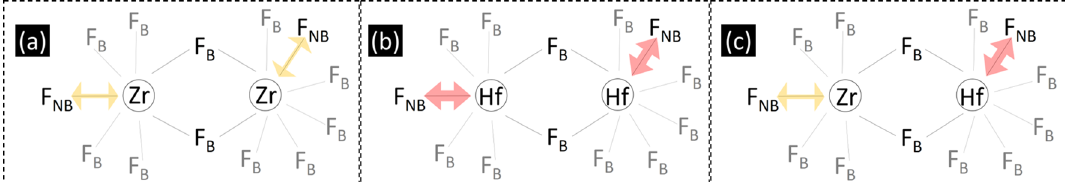
Figure 10. Electron cloud of terminal/non-bridging fluorines(F NB ) experiencing ( a ) moderate distortion from Zr atoms in pure ZBLAN glasses ( b ) High distortion from Hf atoms in pure HBLAN glasses ( c ) terminal fluorines with diverse characteristics due to site specificity depending on its immediate neighbour in hybrid